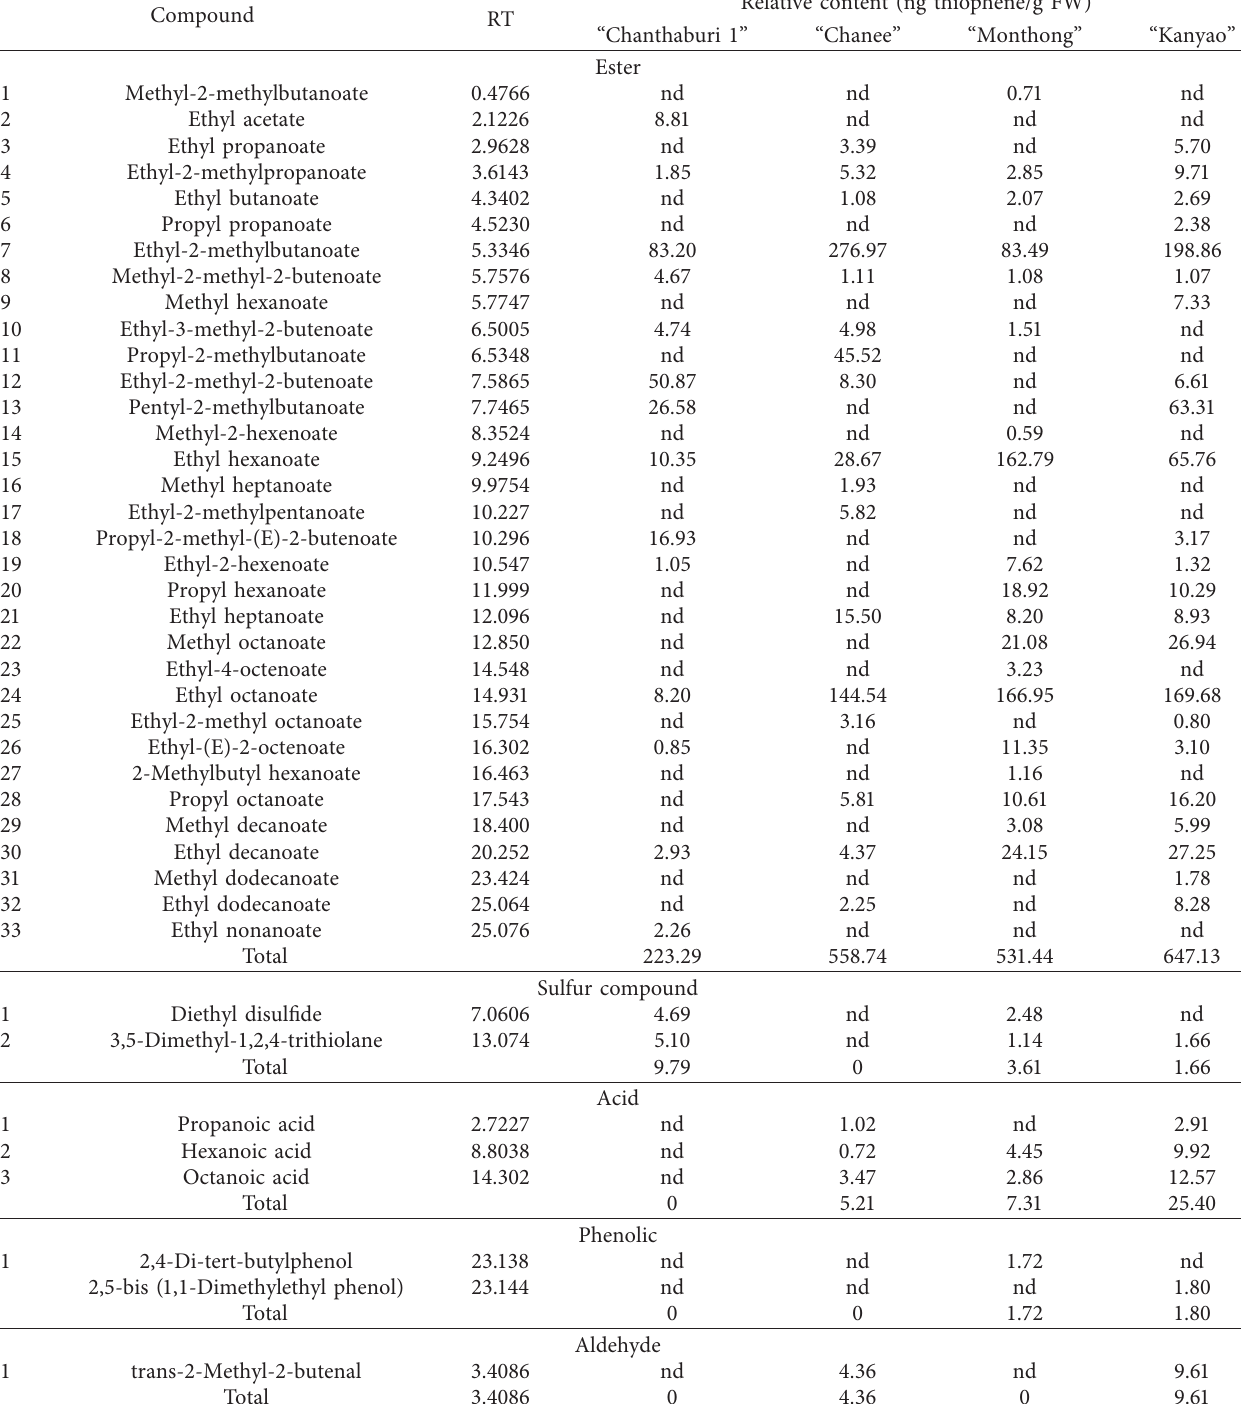
Table 1: Volatile compounds released from ripe flesh of 4 Thai durian fruits corresponded to the GC-MS chromatogram